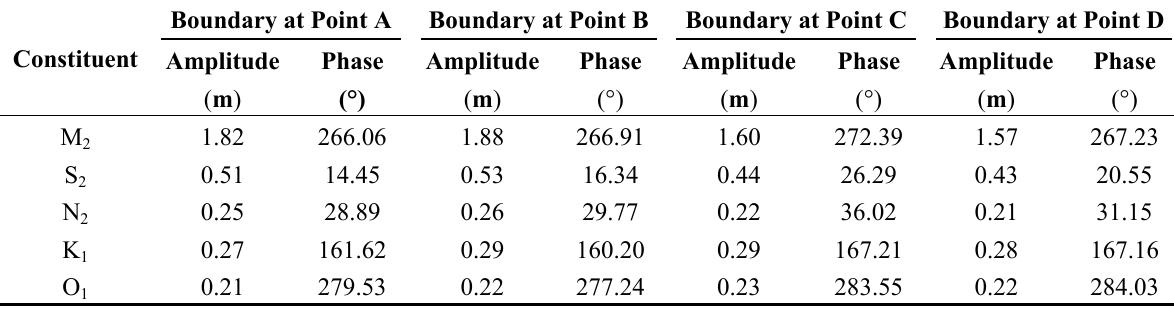
Table 1. The amplitudes and phases used for the model simulation at the coastal sea boundaries.